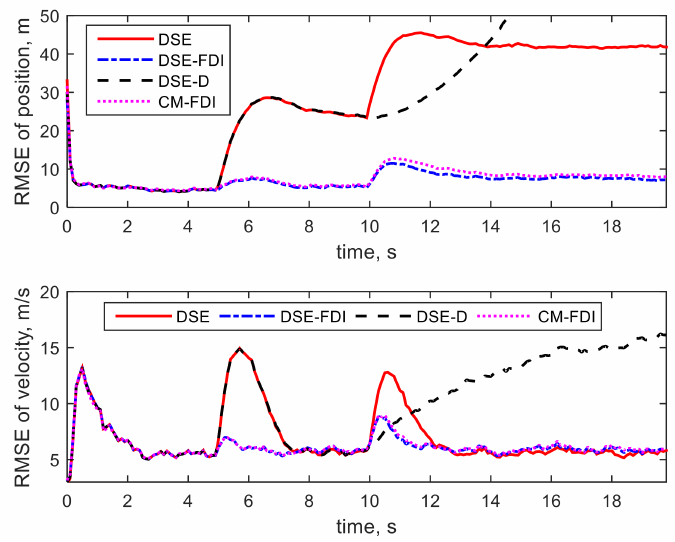
Figure 9. RMSE of the position and velocity over time for different